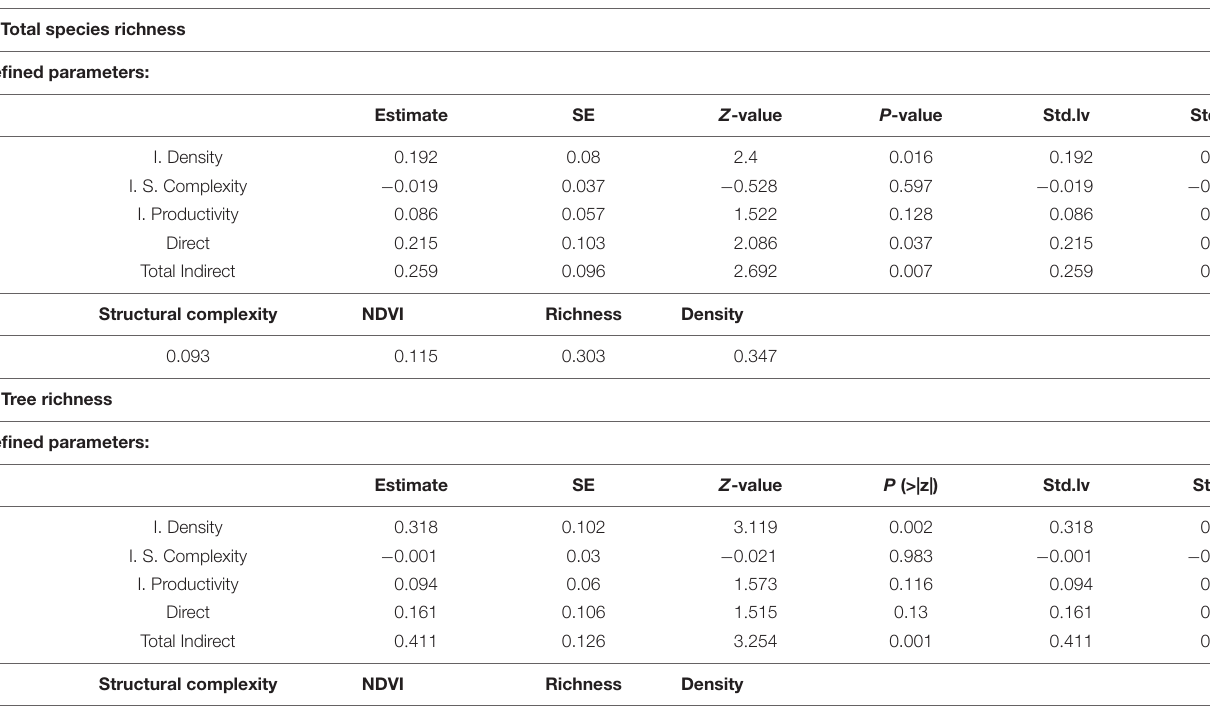
TABLE 1 | Results of structural equation models (SEMs) showing the estimates, standard errors (SE), Z -value, P -value, standardized coefficient of latent variables (Std.Iv), and completely standardized solution